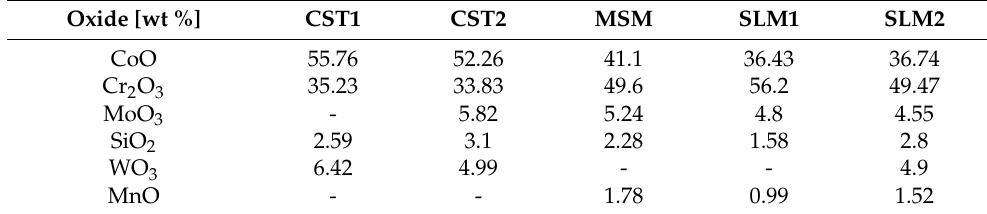
Table 4. contains data summarizing the contribution of particular oxides covering the surface of thermally treated alloys (based on the quantitative EDS results concerning the average oxides contribution (panels (a) of Figures 3–7)). Table 4. Oxide content on the alloys’ surface after the HT